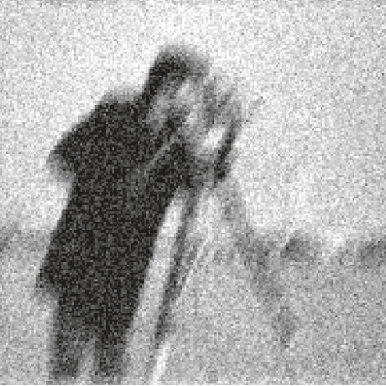
Figure 9: Camera picture which was degraded by L = 20 pixels, φ = 60 ◦ and Gaussian additive noise (SNR = 30dB). Estimated values for this image using our algorithm were L = 21 . 8 pixels and φ = 58 . 7 ◦ .